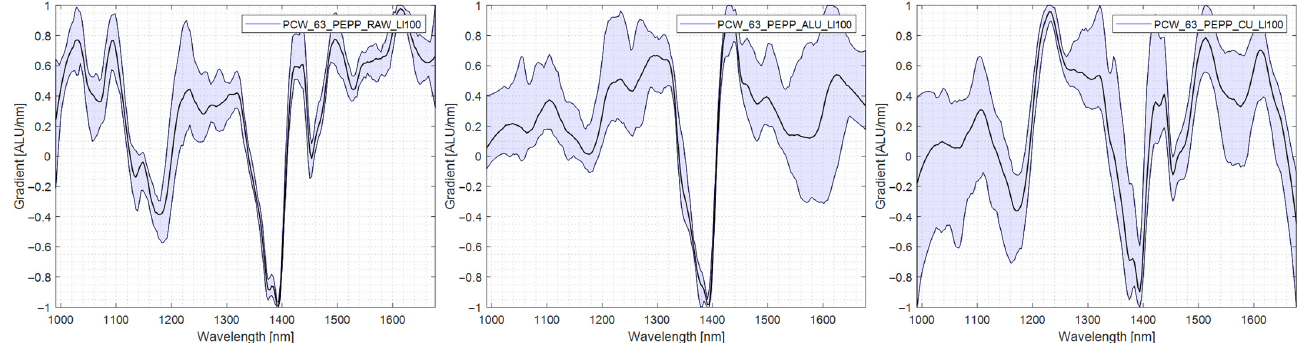
Figure 18. Comparison PE/PP spectra, left: no reflector, middle: aluminium reflector, right: copper Reflector.